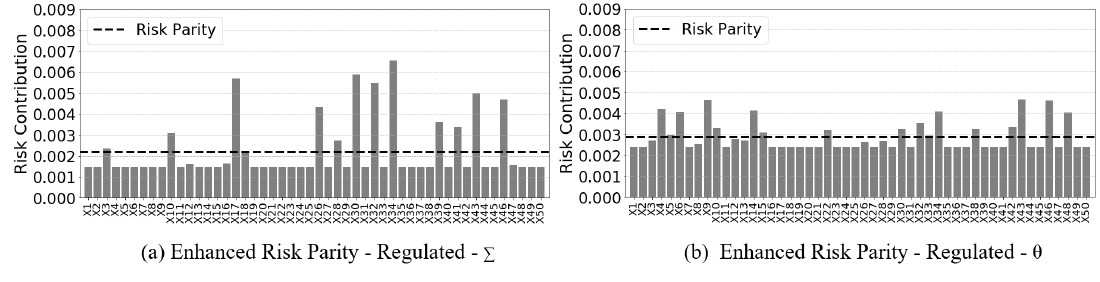
Figure 4. Risk contribution concentration in Model (B)—50 assets, 1997 to 2018-1.1x